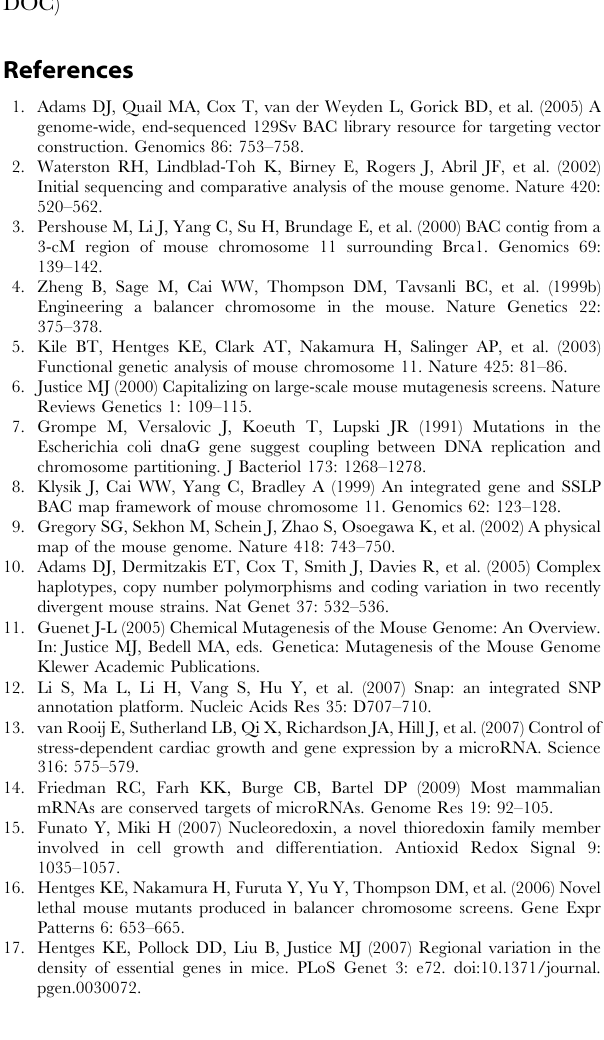
DNA from a heterozygous mutant was used for re-sequencing. F: Denotes forward gene, forward strand sequence provided (coding sequence). R: Denotes reverse gene, reverse complement of forward strand sequence provided (coding sequence). 1 Twelve lesions did not confirm in any animals giving an error rate for re-sequencing of 15% (12/80). 2 Mutation was discovered independently of chr 11 resequencing effort. 3 Unable to suc- cessfully PCR and amplify and sequence the genomic region flanking this mutation so this mutation was not confirmed. 4 Kile,